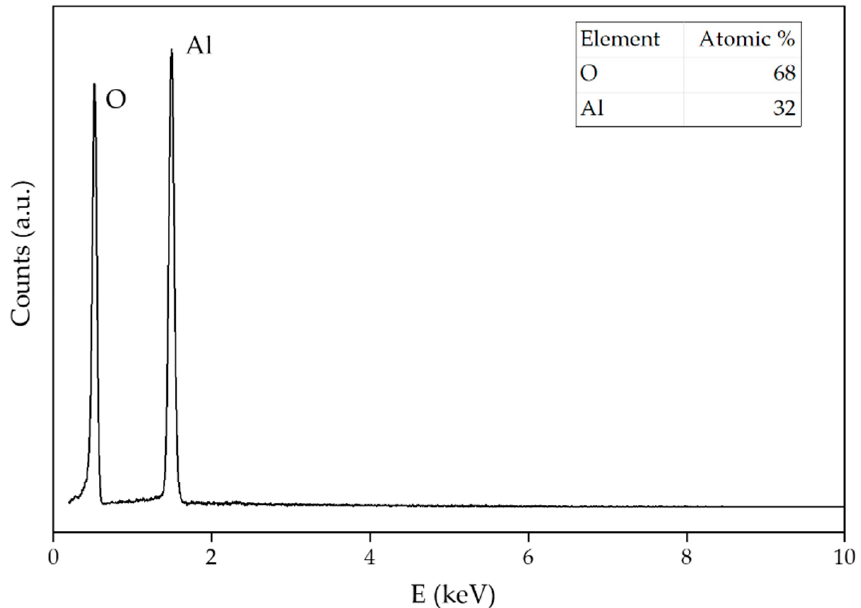
Figure 4. The EDS pattern of boehmite NPs. The results of the element analysis are shown in the inset.